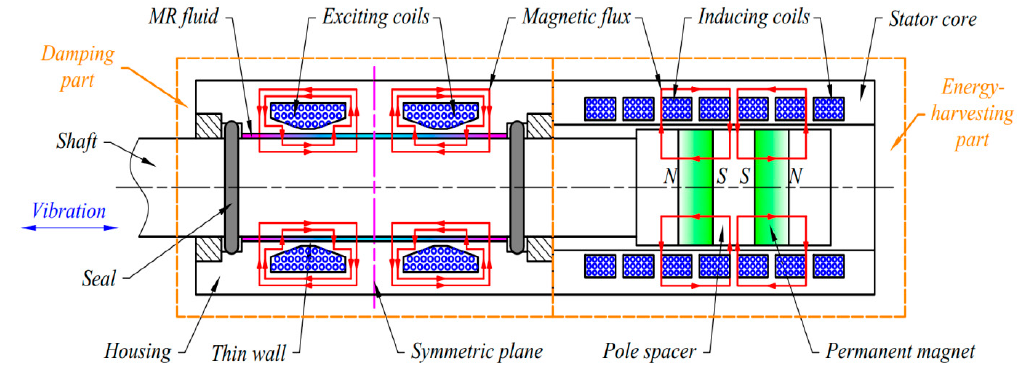
Figure 2. Schematic of the proposed self-powered shear-mode magnetorheological (MR) damper.